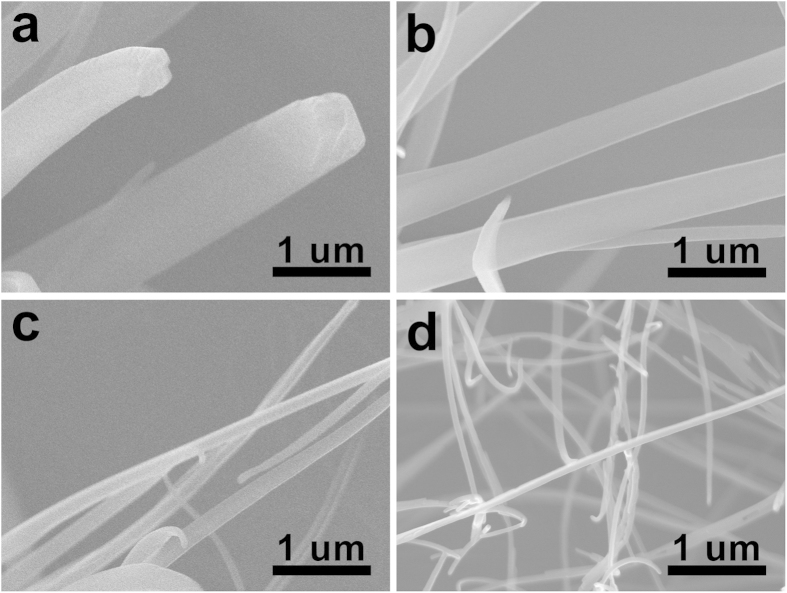
Kinetic control of the width of RB-NWBA as a function of cooling rate (vcooling) in a strong hypereutectic regime (fBA = 0.9); (a) W = 755 ± 90 nm at vcooling = −5 °C/min, (b) W = 358 ± 48 nm at vcooling = −10 °C/min, (c) W = 199 ± 42 nm at vcooling = −15 °C/min, (d) W = 78 ± 25 nm when the temperature was abruptly dropped from 130 °C to 25 °C.